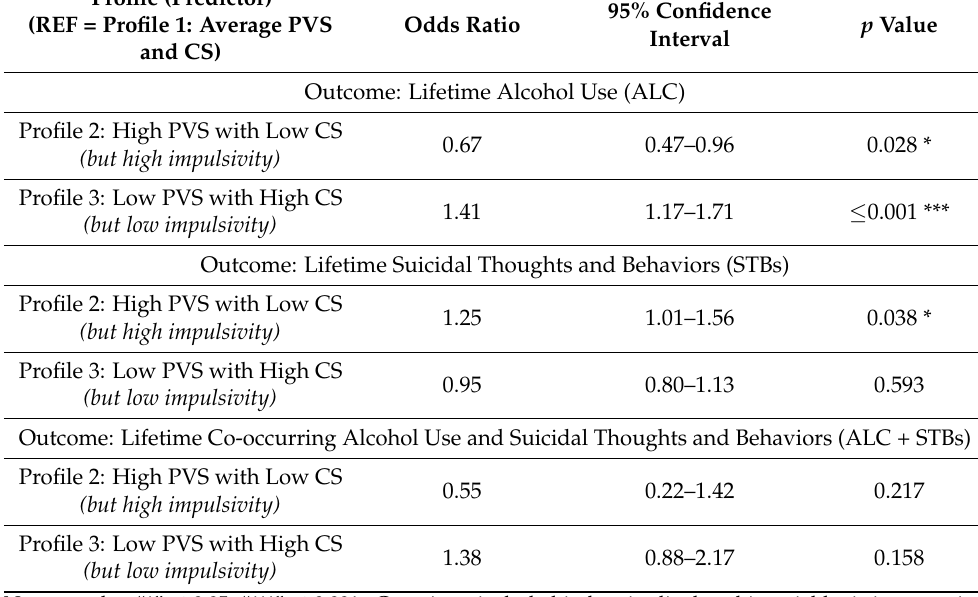
Table 3. Longitudinal multinomial logistic regression standardized models for baseline profiles (predictors) showing associations with year two follow-up classification of lifetime alcohol use (ALC), lifetime suicidal thoughts and behaviors (STBs), and lifetime co-occurring ALC + STBs (outcomes). Profile